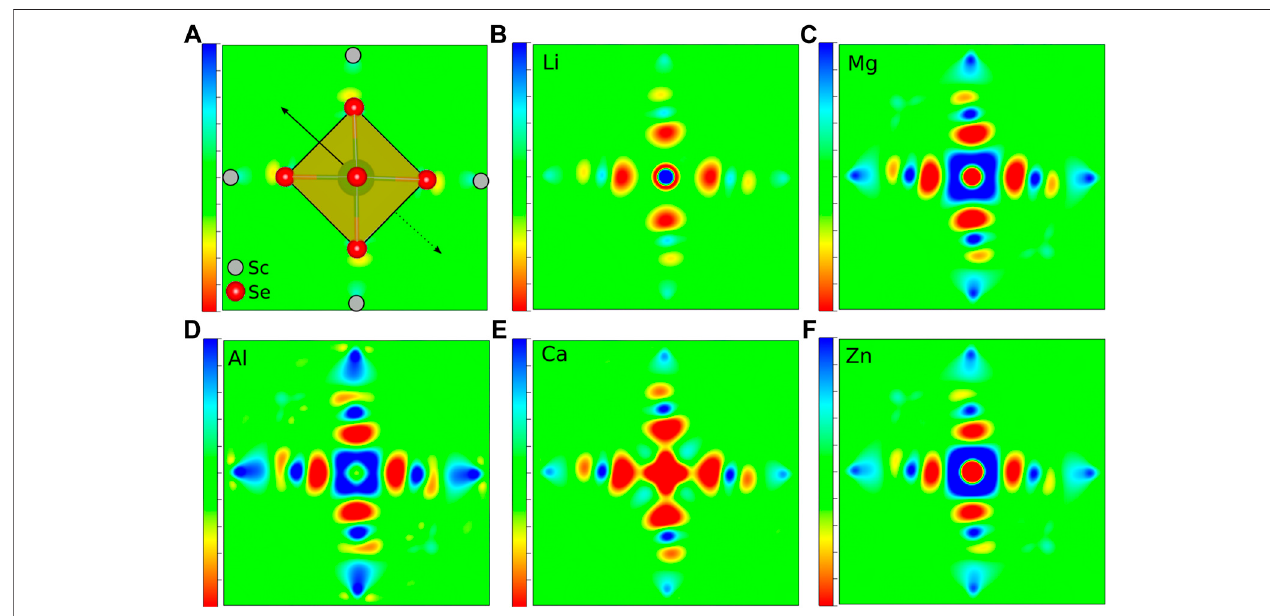
FIGURE 4 | Charge density difference contour plots of MgSc 2 Se 4 structures with (A) a schematic presentation, (B) Li, (C) Mg, (D) Al, (E) Ca, and (F) Zn atoms in octahedral coordination. Areas of charge depletion are shown in blue and areas of charge accumulation are shown in red. The solid arrow indicates the displacement of the upper Se atom, while the dashed arrow shows the opposing shift of the Se atom below the